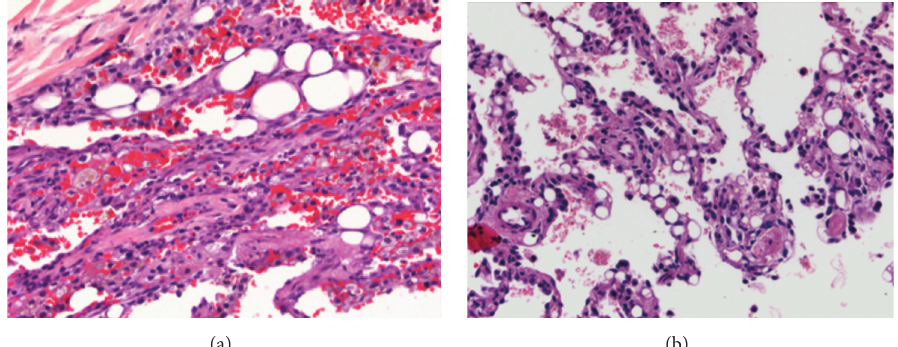
Figure 2: (a) Lung parenchyma with intra-alveolar hemorrhage, multiple vacuoles, macrophages, and dilated capillaries (40X). (b) Lung parenchyma with dilated capillaries and nonrefractile vacuole-like structures